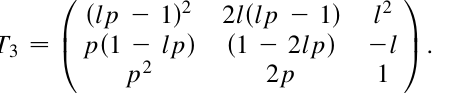
FIG. 8. Dependence of the b function of one particle on the azimuth along the arc. The counter particles act as lenses at points 0 and l (cid:3) 2